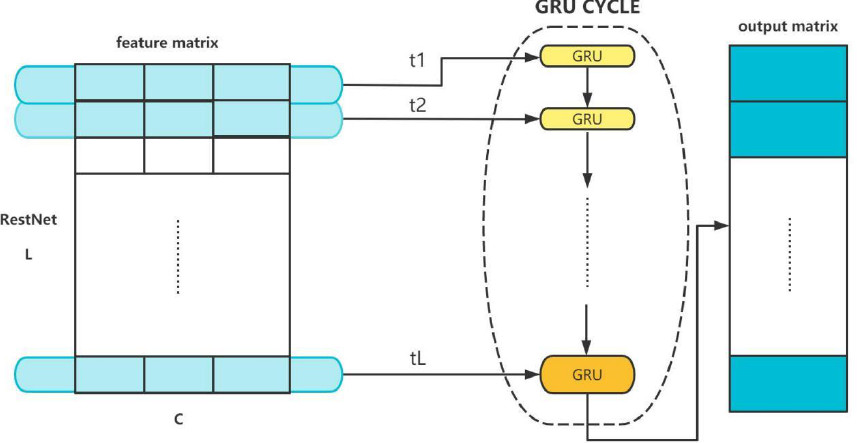
Figure 7. The timing signal through the residual network is connected to the GRU module.